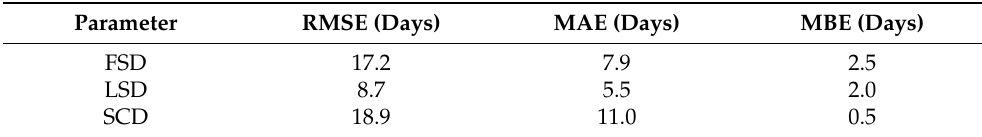
Table 5. Root Mean Squared Error (RMSE), Mean Absolute Error (MAE), and Mean Bias Error (MBE) calculated comparing snow seasonal parameters (First Snow Day, FSD, Last Snow Day, LSD, and Snow Cover Duration, SCD) of overall predicted snow cover data and weather